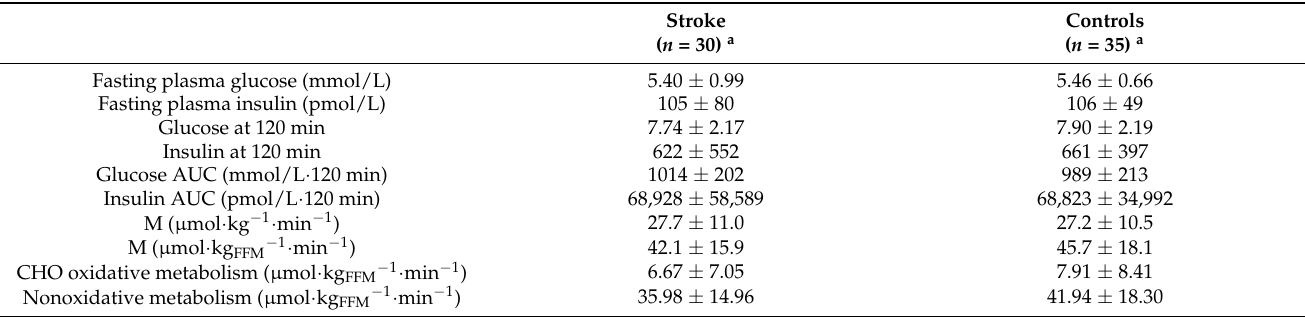
Table 2. Glucose